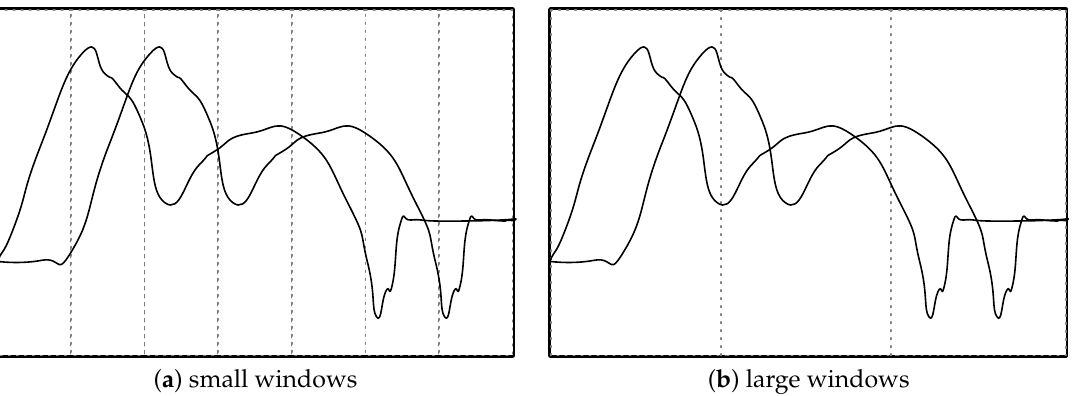
Figure 11. Comparison of window sizes with two similar signals. The peak values of the signals on the left reside in different windows. In contrast, the peak values on the right reside in the same